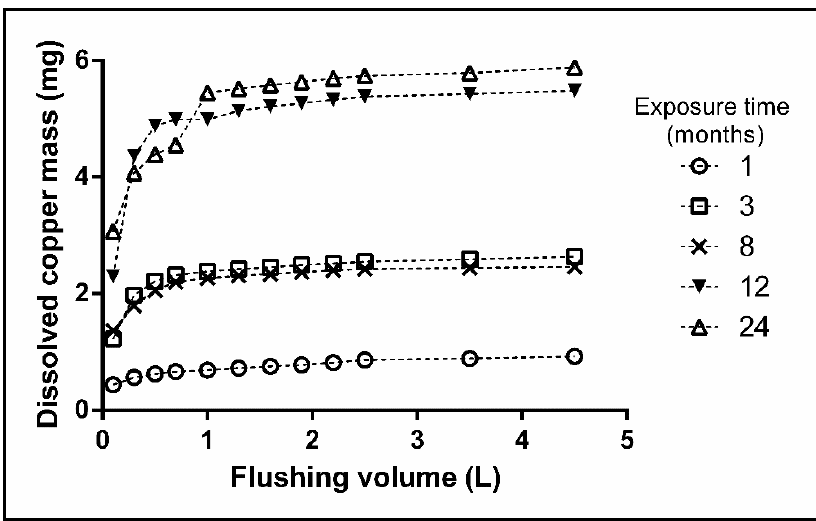
Figure 3. The average value of dissolved copper mass released from the copper pipe during flushing experiments.